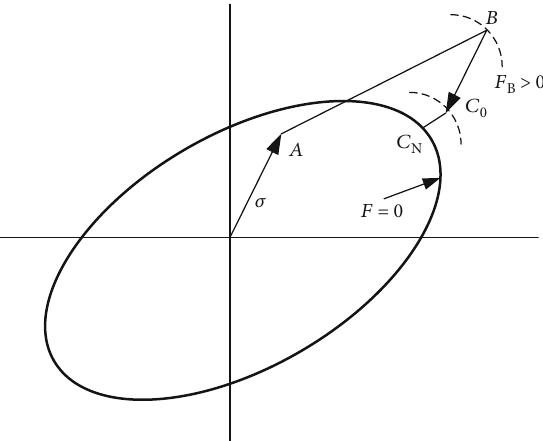
Figure 4: Sketch map of the backward Euler integration